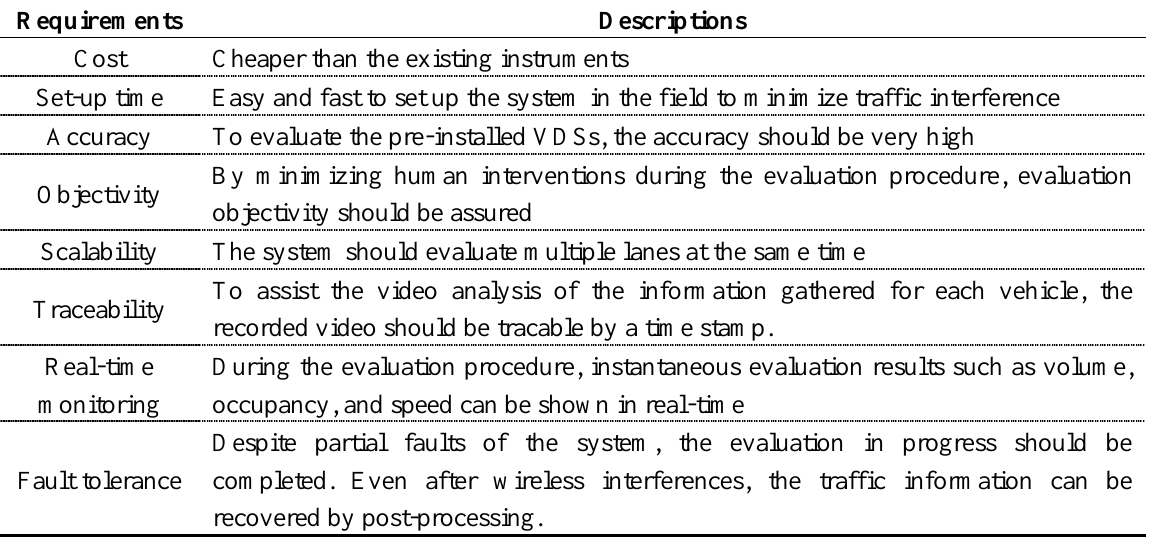
Table 1. Requirements for a new portable evaluation